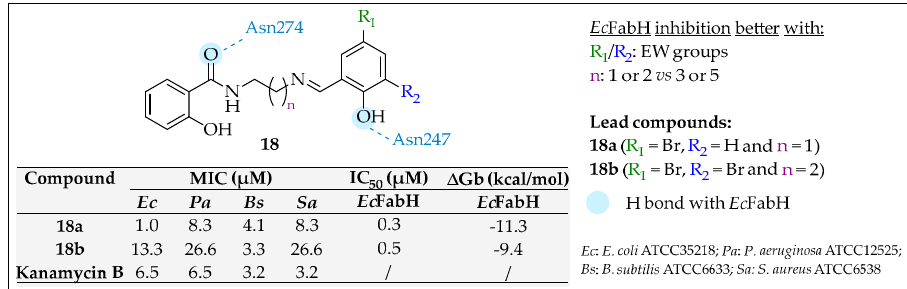
Figure 14. Structures and representation of main interactions with Ec FabH of SB414011 , 15–17 and in vitro activities of lead compounds [36,86].